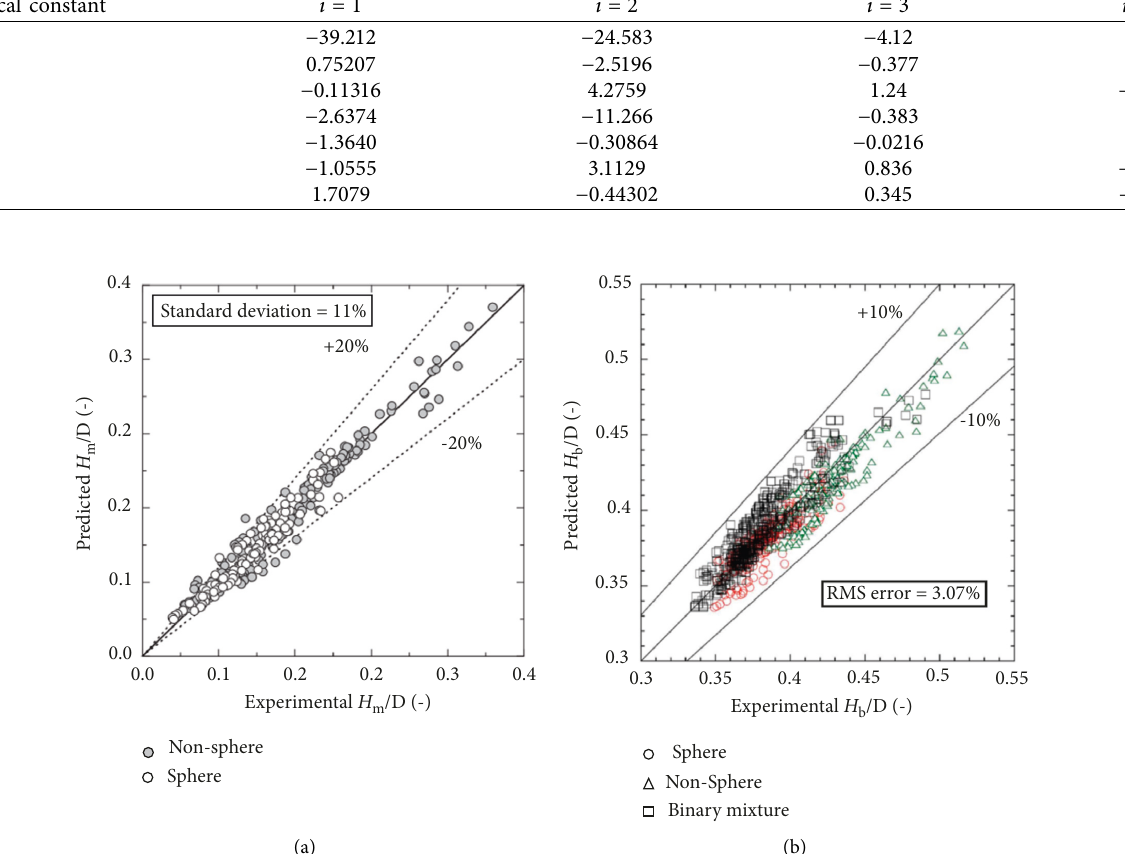
Figure 17: Comparison of mound and bed heights between experiments and modeling predictions [43, 46] (a) Mound height (b) Bed height.